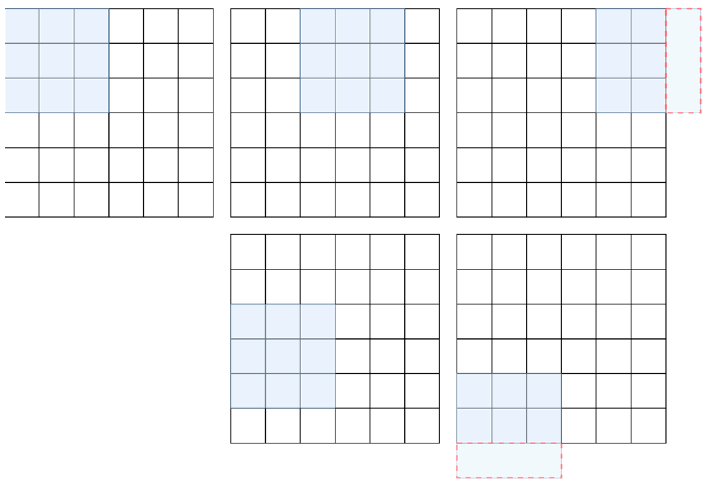
Figure 12. Schematic of convolution with stride =